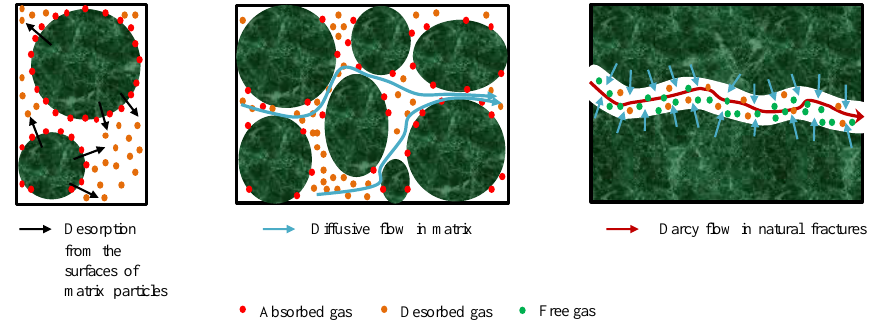
Figure 2. Schematic of the gas desorption, diffusion, and Darcy flow in CBM reservoirs (modified after Zhao et al. [19]).